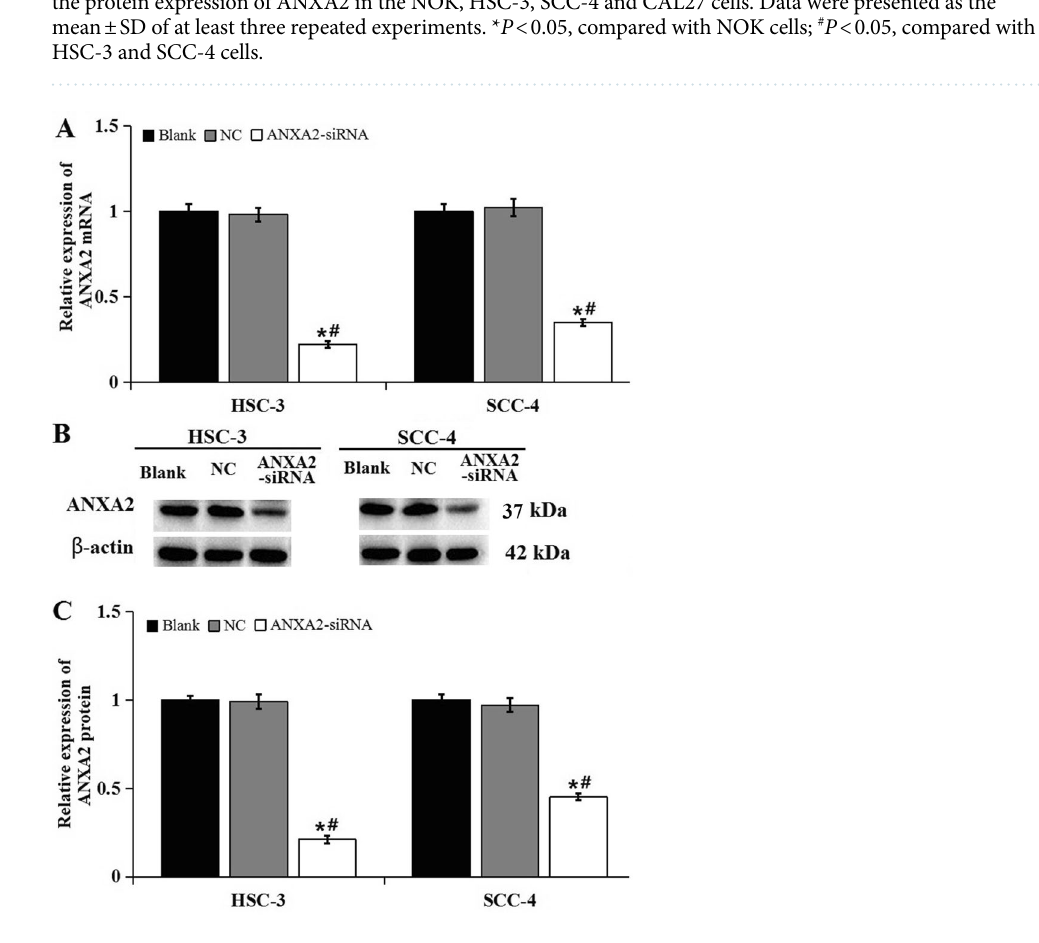
Figure 4. Expression of ANXA2 after transfection with siRNA. ( A ) RT-PCR showed mRNA expression of ANXA2 after transfection with siRNA in HSC-3 and SCC-4 cells. ( B ) Western blot showed the protein expression of ANXA2 after transfection with siRNA in HSC-3 and SCC-4 cells. ( C ) Relative expression of ANXA2 after transfection with siRNA in HSC-3 and SCC-4 cells. Data were presented as the mean ± SD of at least three repeated experiments. * P < 0.05, compared with blank group; # P < 0.05, compared with NC